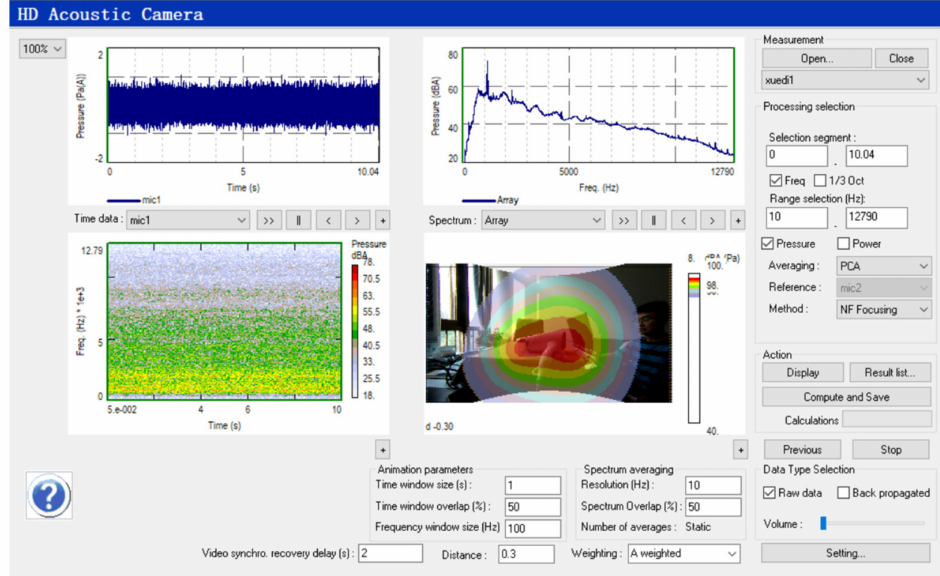
Figure 8. LMS Acoustic Camera